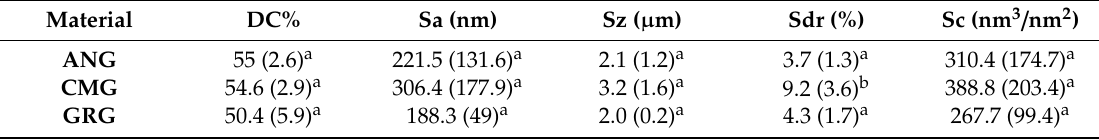
Table 3. The results of the DC% and surface roughness parameters (means and standard deviations). Material